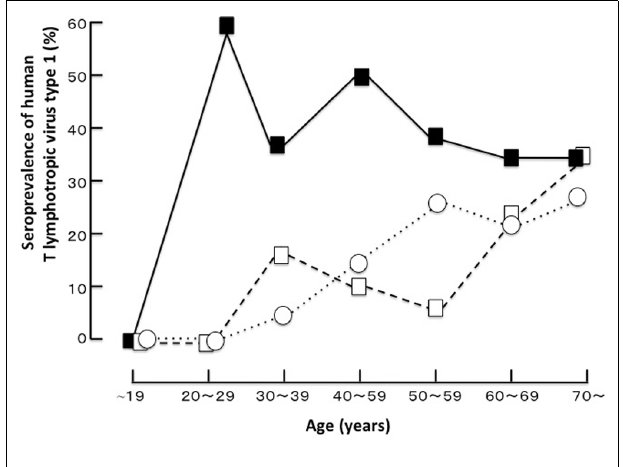
FIGURE 1 |The age distribution of the seroprevalence of humanT cell lymphotropic virus type 1 in a highly endemic area (Miyakonojo, southern Kyushu, Japan; Shirao etal., 1993 with permission). (cid:2) , patients with idiopathic uveitis; (cid:3) , patients with uveitis from a defined cause; (cid:2) , patients with non-uveitic ocular